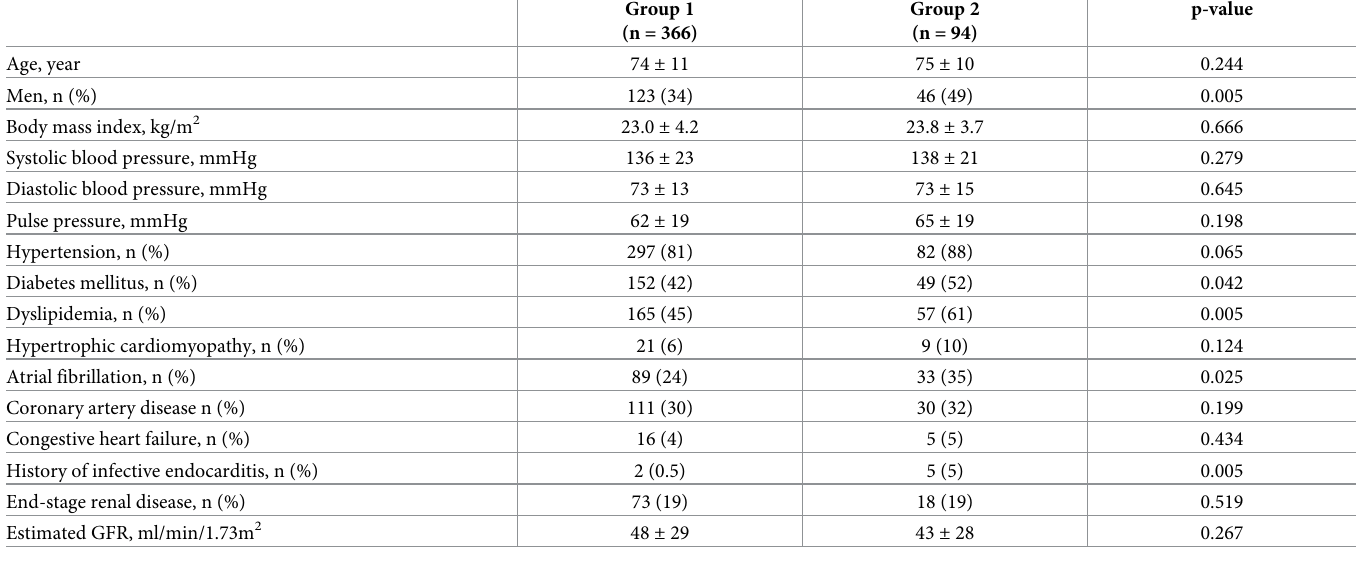
Table 1. Baseline